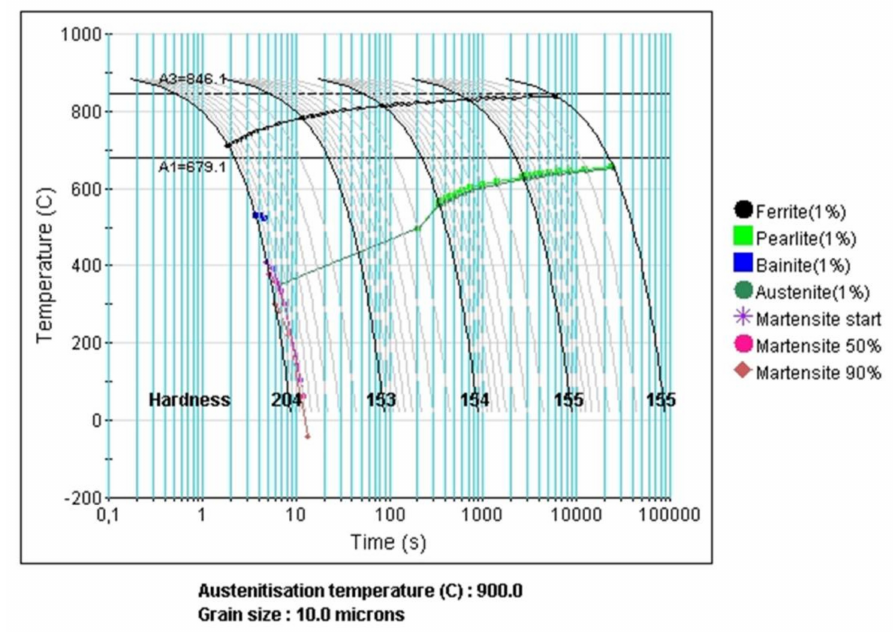
Figure 2. Calculated continuous cooling transformation (CCT) diagram of the material quenched from 900 ◦ C with a grain size of 10 µ